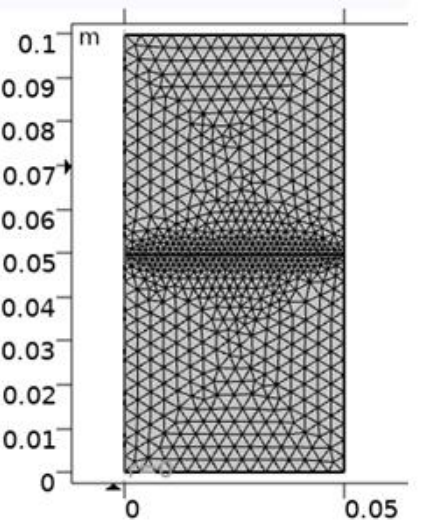
Figure 2. The computational mesh of the COMSOL Multiphysics model. In all numerical models representing MGR21-MGR24, MGR27 experiments it was represented that hydration by water takes place through the bottom boundary of the com- putation